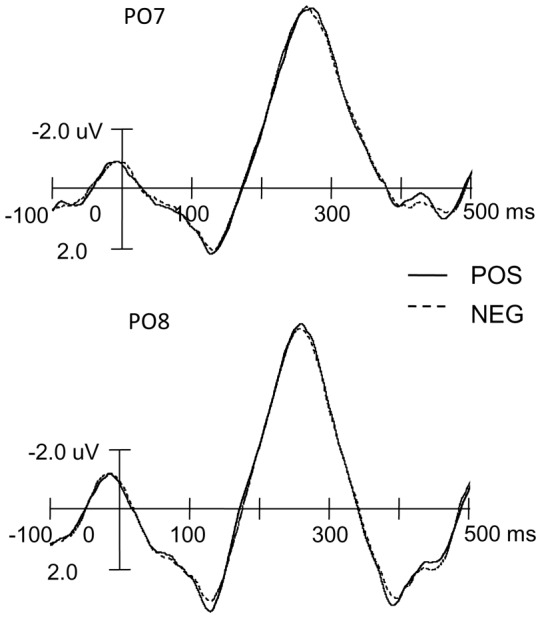
The comparison between positive (POS) and negative (NEG) emotional states.